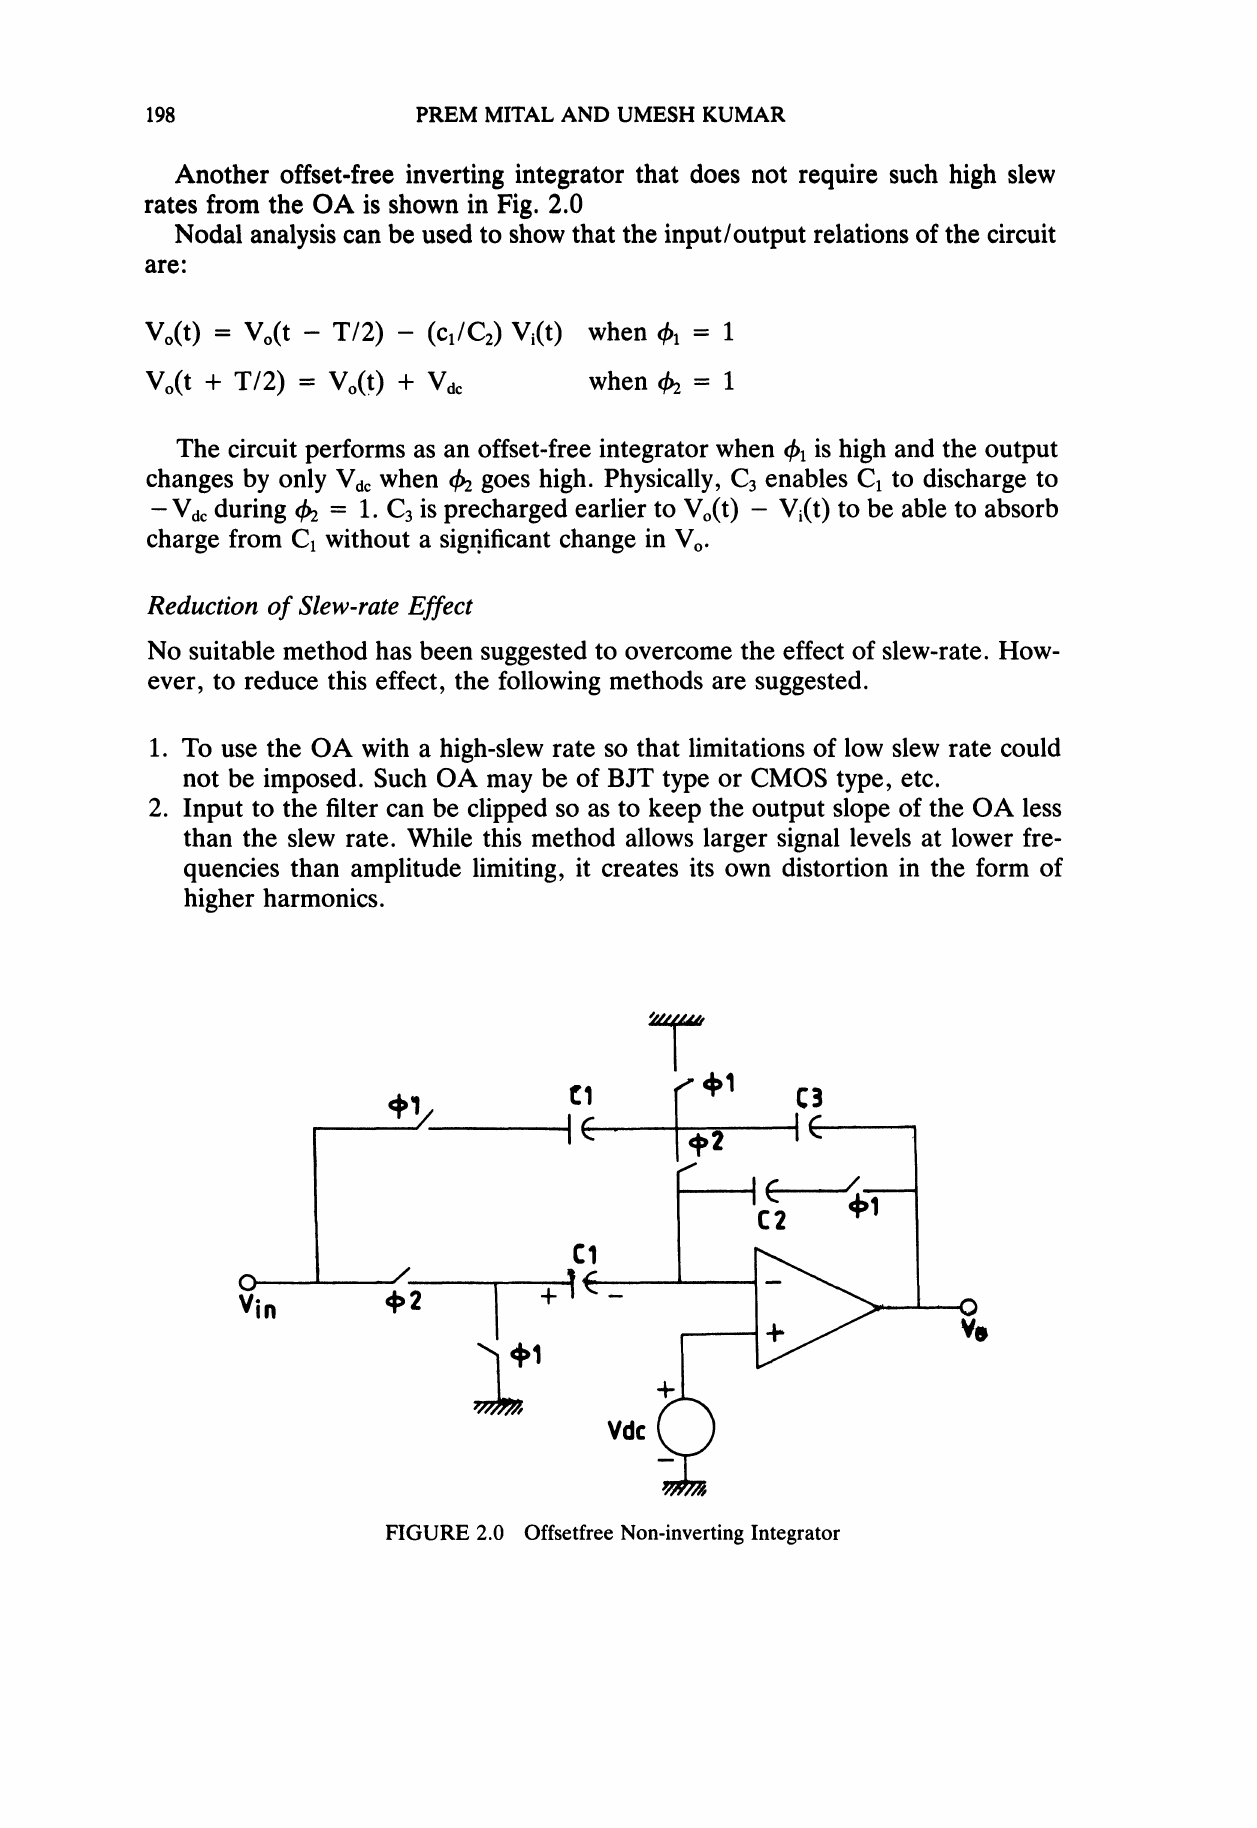
FIGURE 2.0 Offsetfree Non-inverting